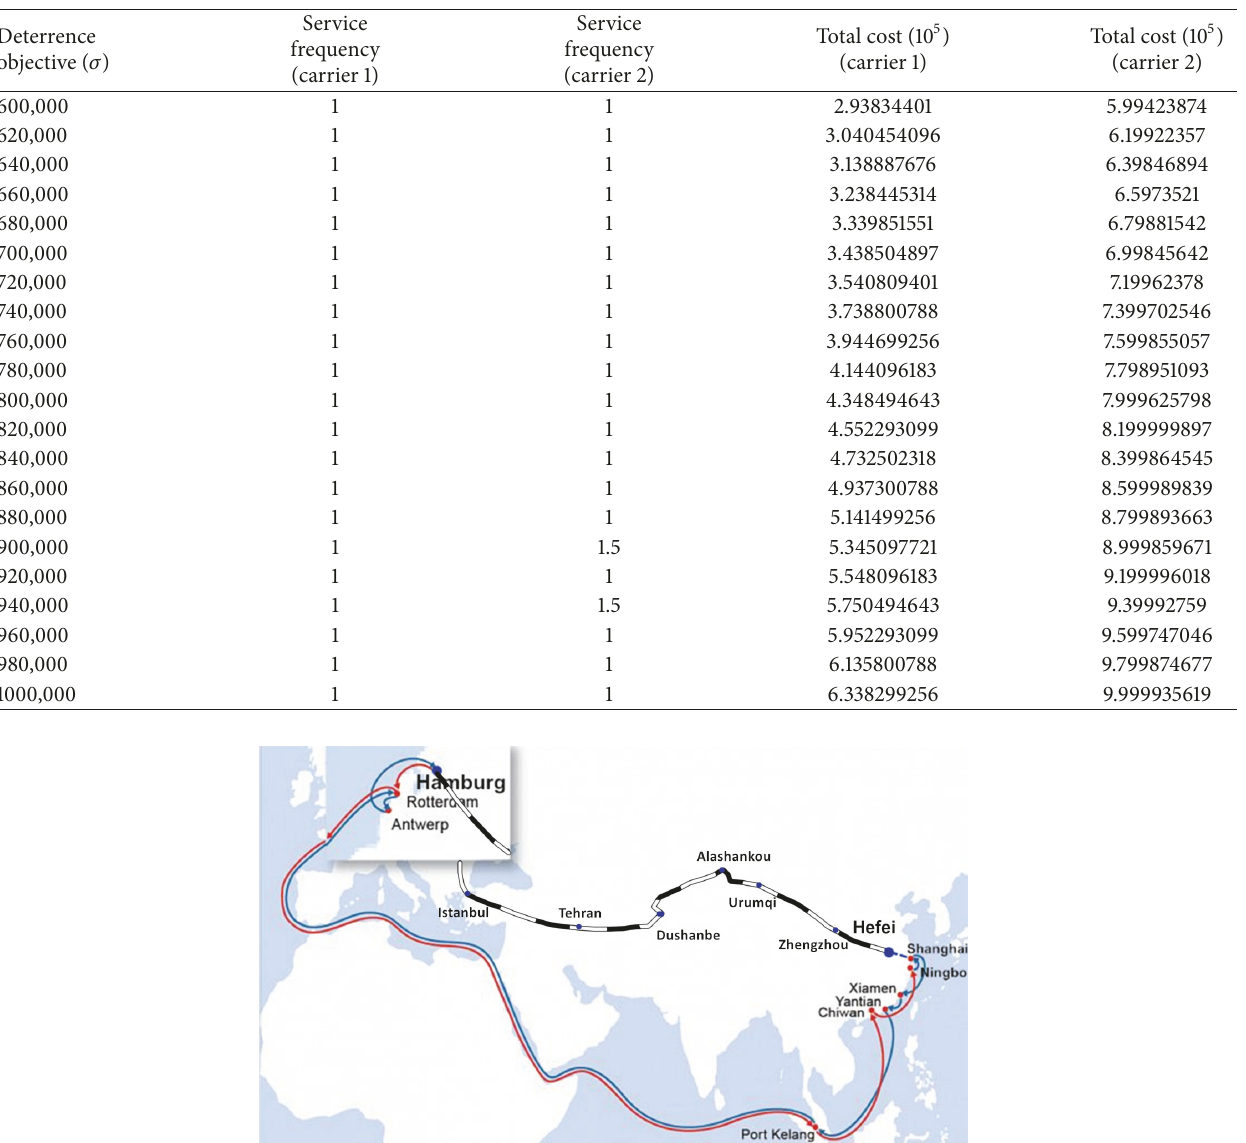
Table 6: Simulated market share of deterrence model.